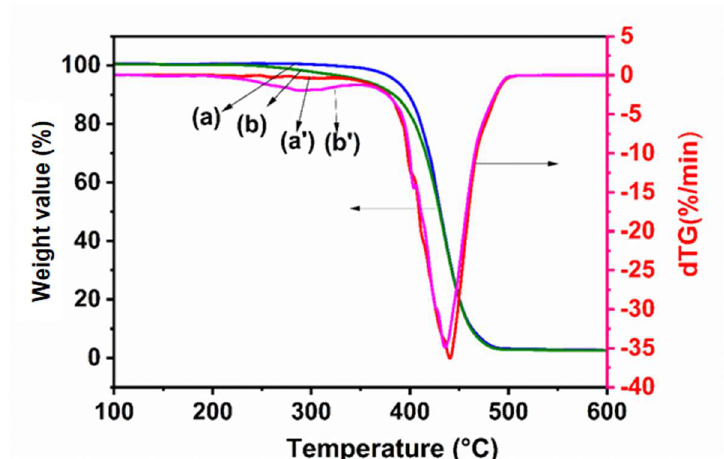
Figure 7. TG/DTG curves under air flow for refined oil (a, a’) and waste oil (b, b’).